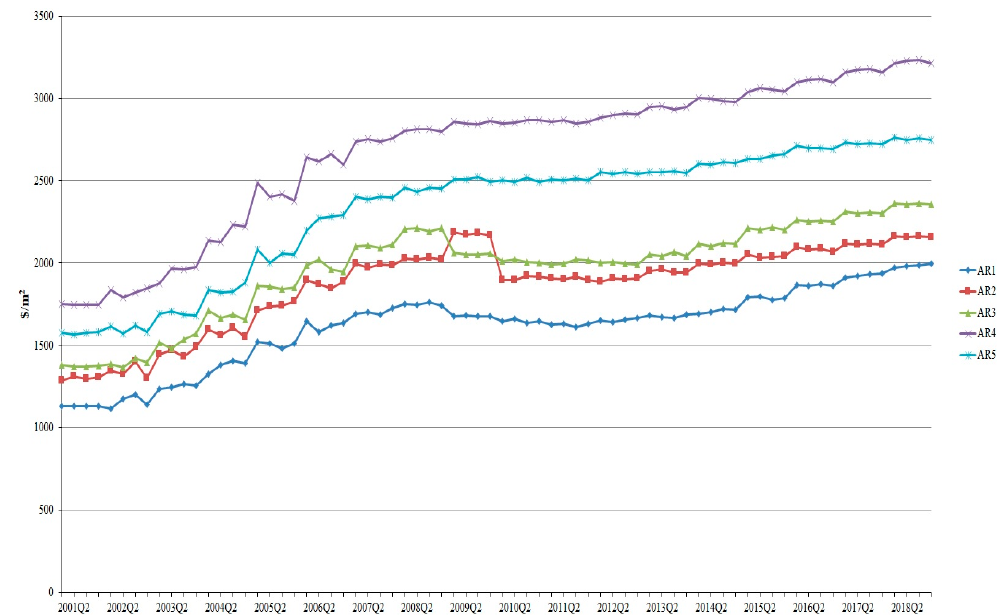
Figure 2. Building cost time series for five categories of residential building in New Zealand.